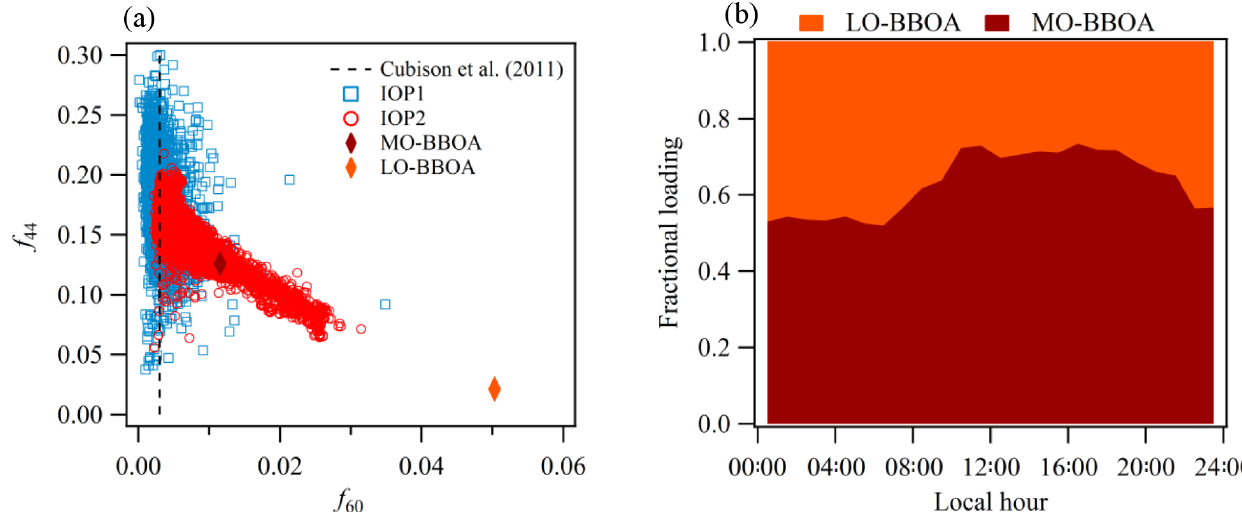
Figure 7. Analysis of the organic PM 1 sampled at the T3 site in relation to biomass burning. (a) Scatter plot of the AMS signal fraction at m/z 44 ( f 44 ) against that at m/z 60 ( f 60 ). Red circles represent measurements during the dry season (IOP2), and blue squares represent measurements at the same site during the wet season (IOP1) (de Sá et al., 2018). Diamonds represent the MO-BBOA and LO-BBOA factors of IOP2. The dashed line represents a reference for negligible influence by biomass burning based on several field studies (Cubison et al., 2011). (b) Diel trends of the fractional loadings of the MO-BBOA and LO-BBOA factors relative to their sum BBOA T . Local time is UTC minus